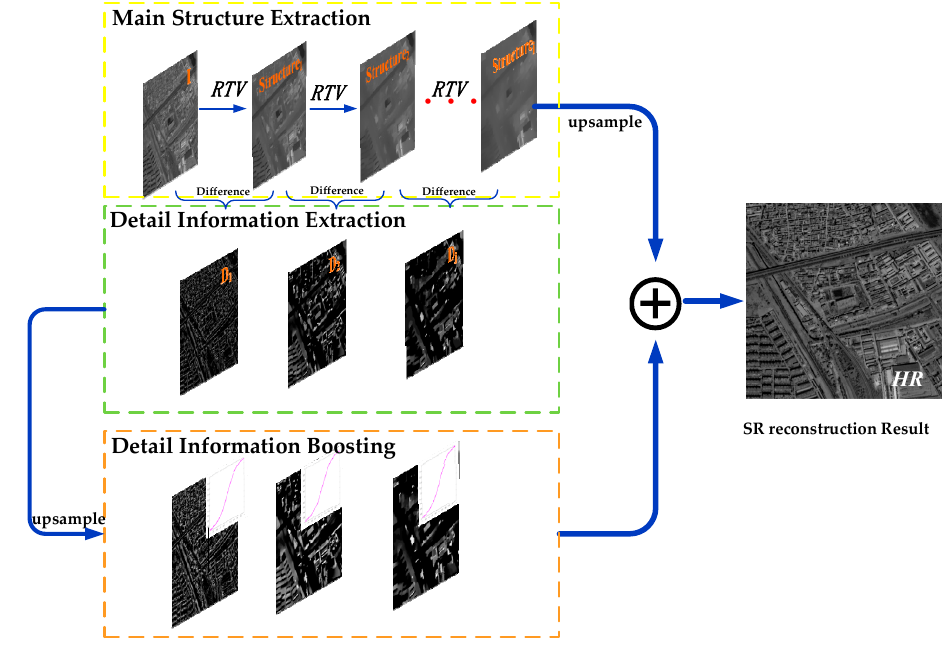
Figure 2. Framework of single-remote-sensing-image super-resolution (SR) reconstruction.